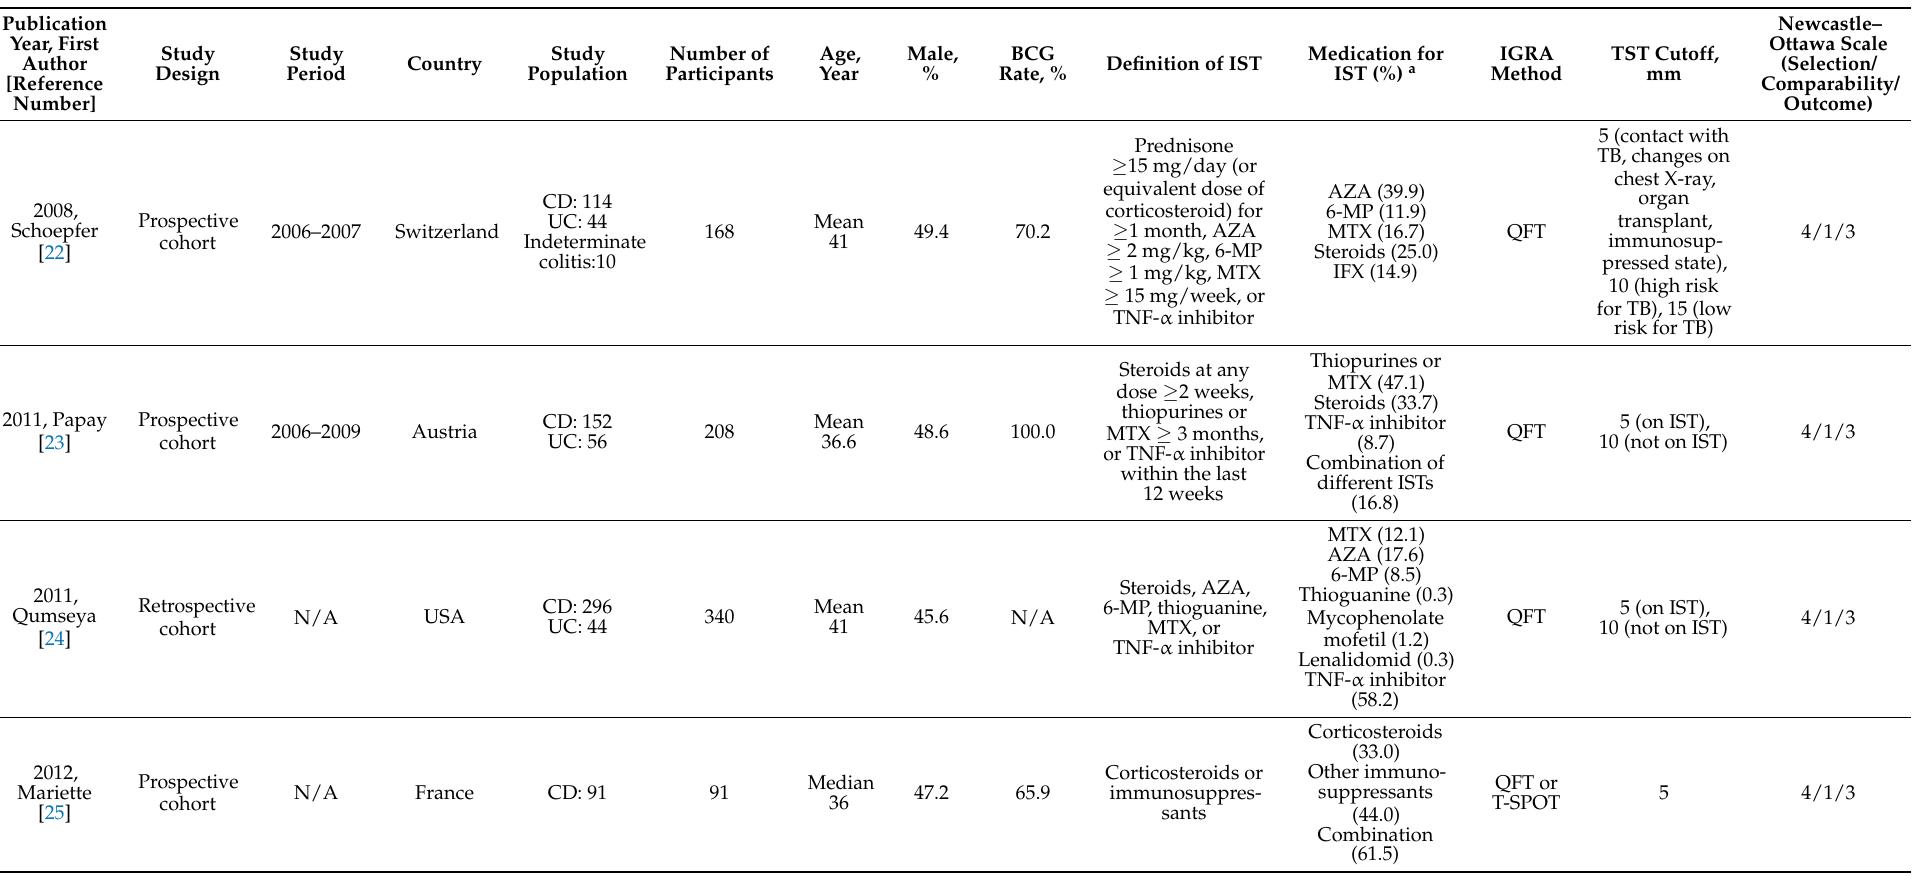
Table 1. Baseline characteristics of included